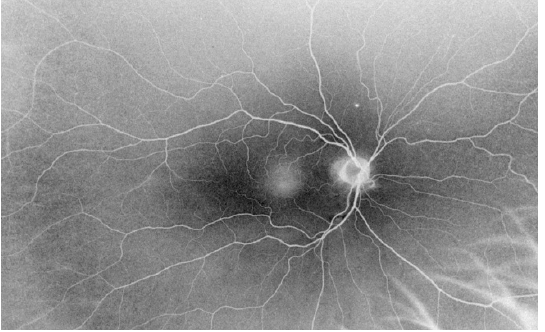
Figure 4. Black-and-white image of the fundus obtained using ultra-wide field laser scanning ophthalmoscopy in a patient with epiretinal membrane.